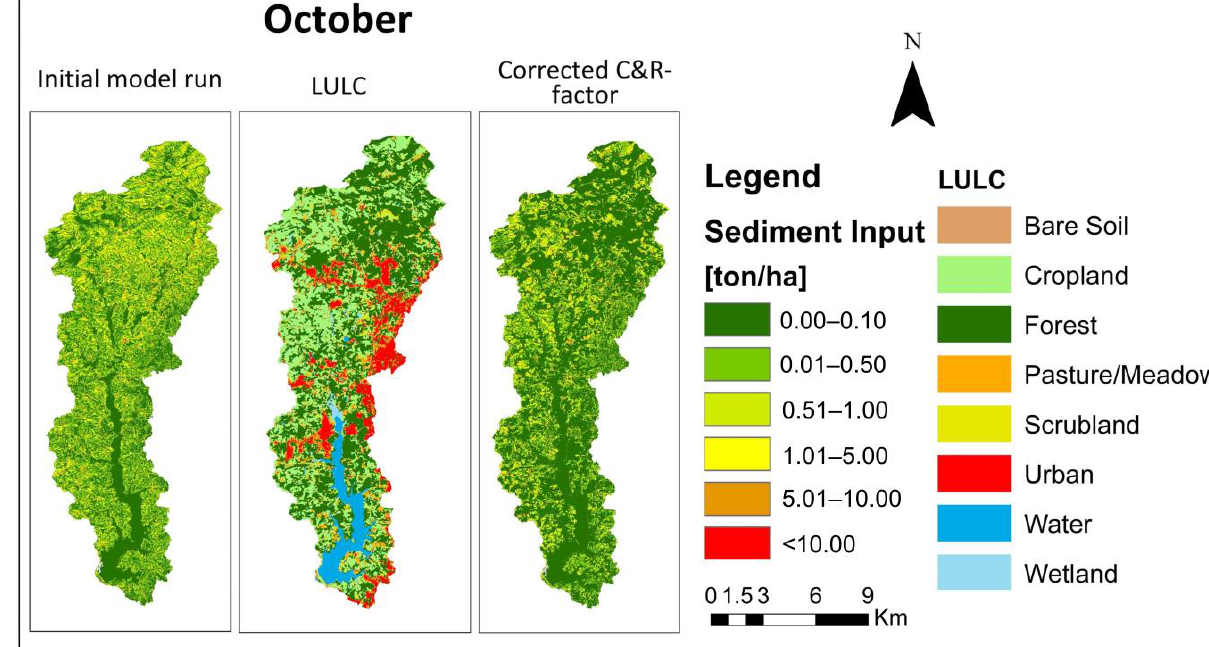
Figure 17. Comparison between initial model run and LULC.